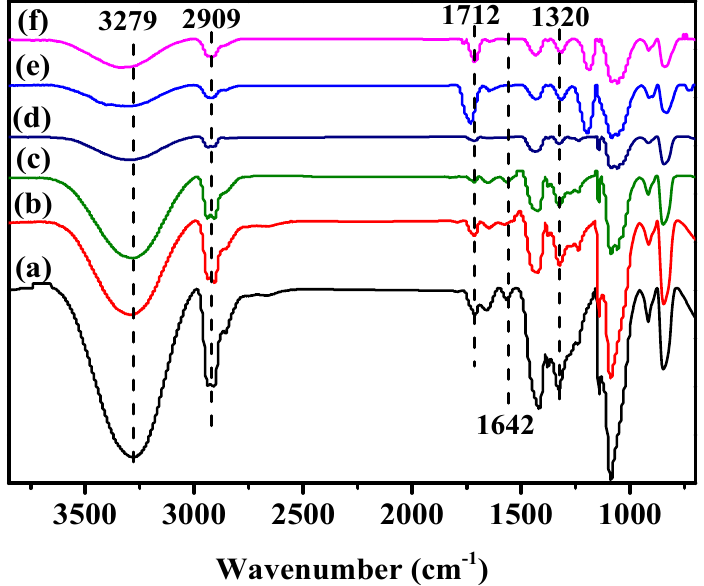
Figure 5. FTIR spectra of different films before and after air plasma treatment. ( a ) PVA film; ( b ) PPVA–3 film; ( c ) CNC/PVA film; ( d ) CNC/PPVA–3 film; ( e ) CNC/OA/PVA film; ( f ) CNC/OA/PPVA–3 film.